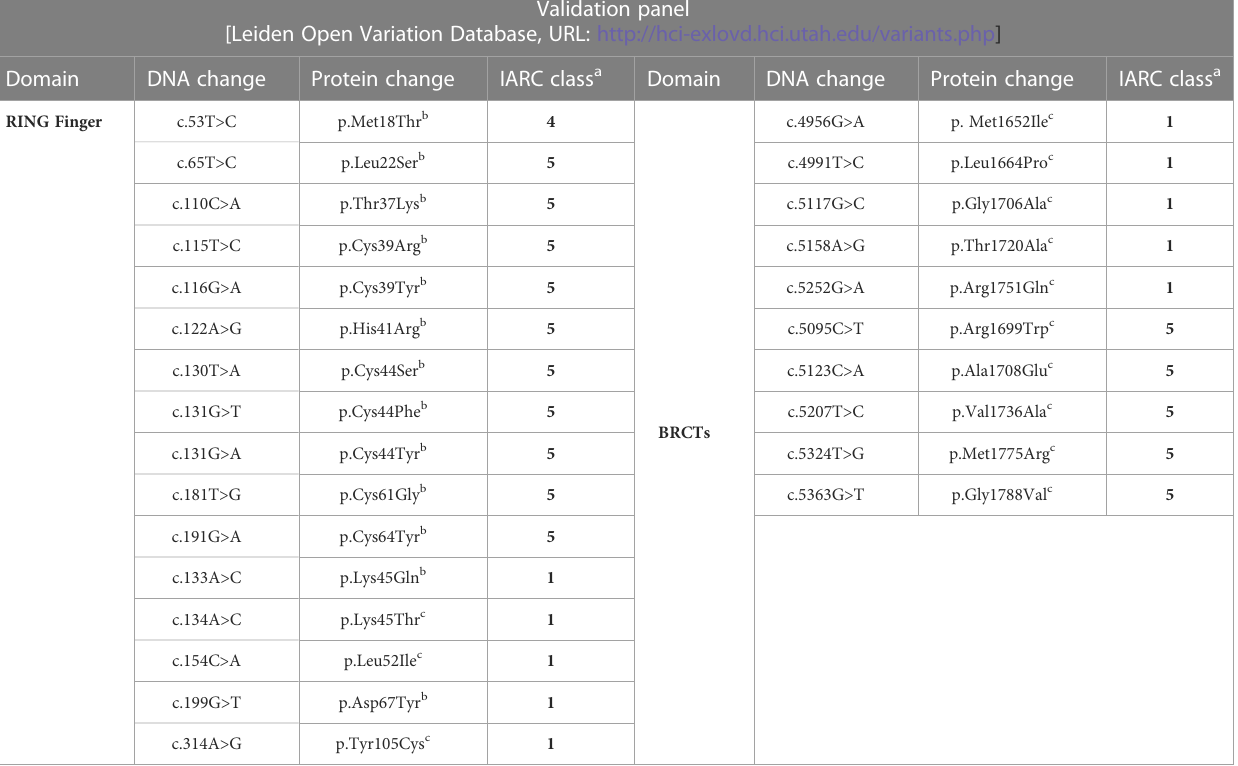
TABLE 1 Variants of validation